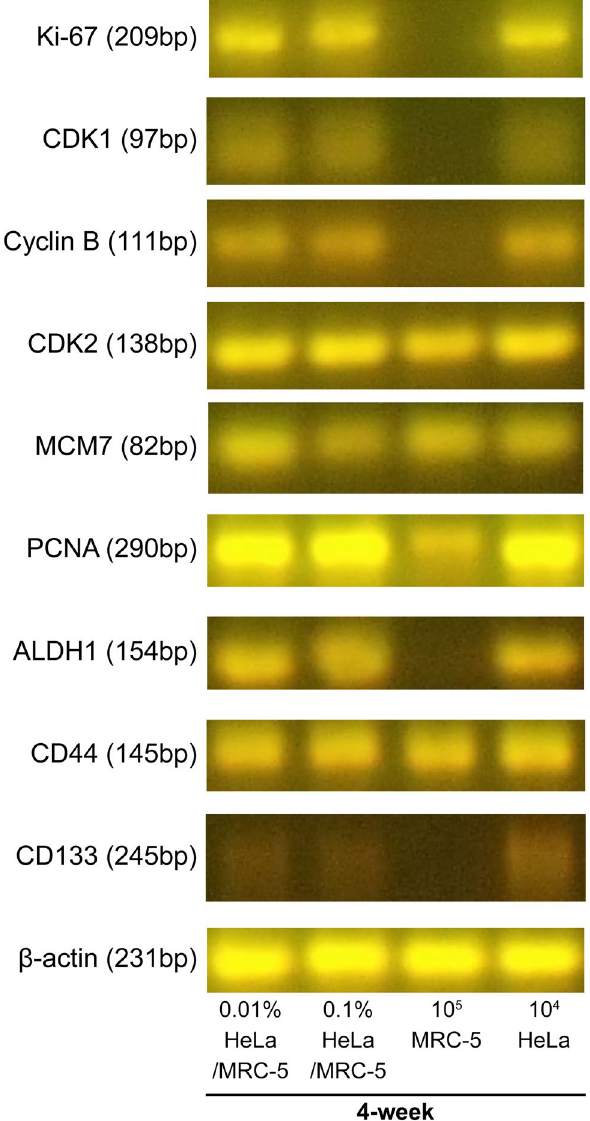
Figure 6. Electrophoresis of PCR products from 4-week cultured cells in soft agar for the long-term culture. PCR products of cell cycle-related mRNAs, CSC markers, and β-actin mRNA. The PCR products of the 0.01% HeLa, 0.1% HeLa, and 10 4 HeLa alone group were observed at the expected size. On the other hand, in the 10 5 MRC-5 alone group, Ki-67, CDK1, cyclin B, ALDH1, and CD133 mRNA were not detected at the expected size. CSC, cancer stem